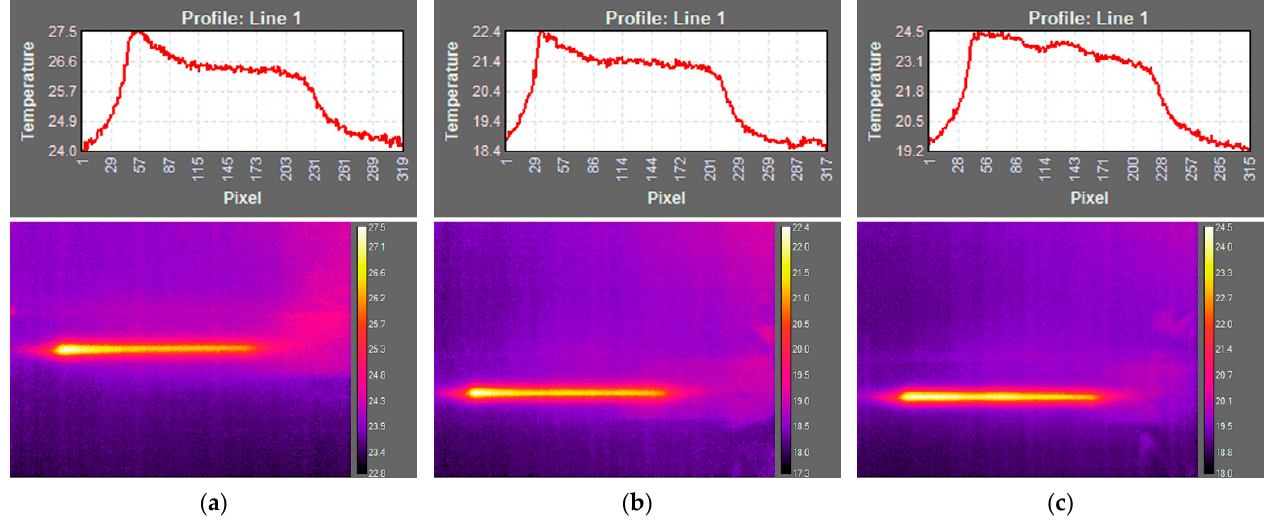
Figure 12. Active thermographic inspection: ( a ) 95 A-11 before loading, ( b ) 95 A-11 after 200 cycles of cyclic flexural loading, ( c ) 95 A-11 after impact.